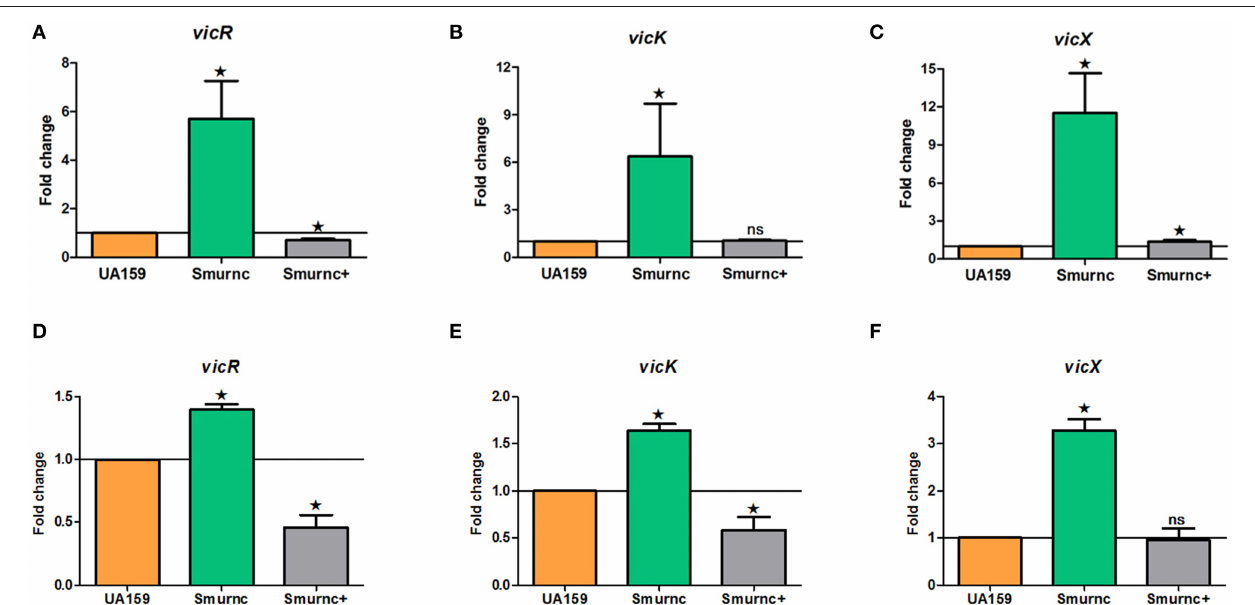
FIGURE 3 | Dynamics of the expression of vicR/K/X genes in interaction with rnc gene among three types of strains. (A–C) Relative expression levels of vicR/K/X were calculated during the mid-exponential phase in vitro . (D–F) Relative expression levels of vicR/K/X were calculated in SPF rat model in vivo . The fold changes were shown after standardization relative to gyrA using UA159 as a reference. The data were represented as the means and standard deviation values. Asterisks indicate significant differences ( P < 0.05 ); ns, no significant